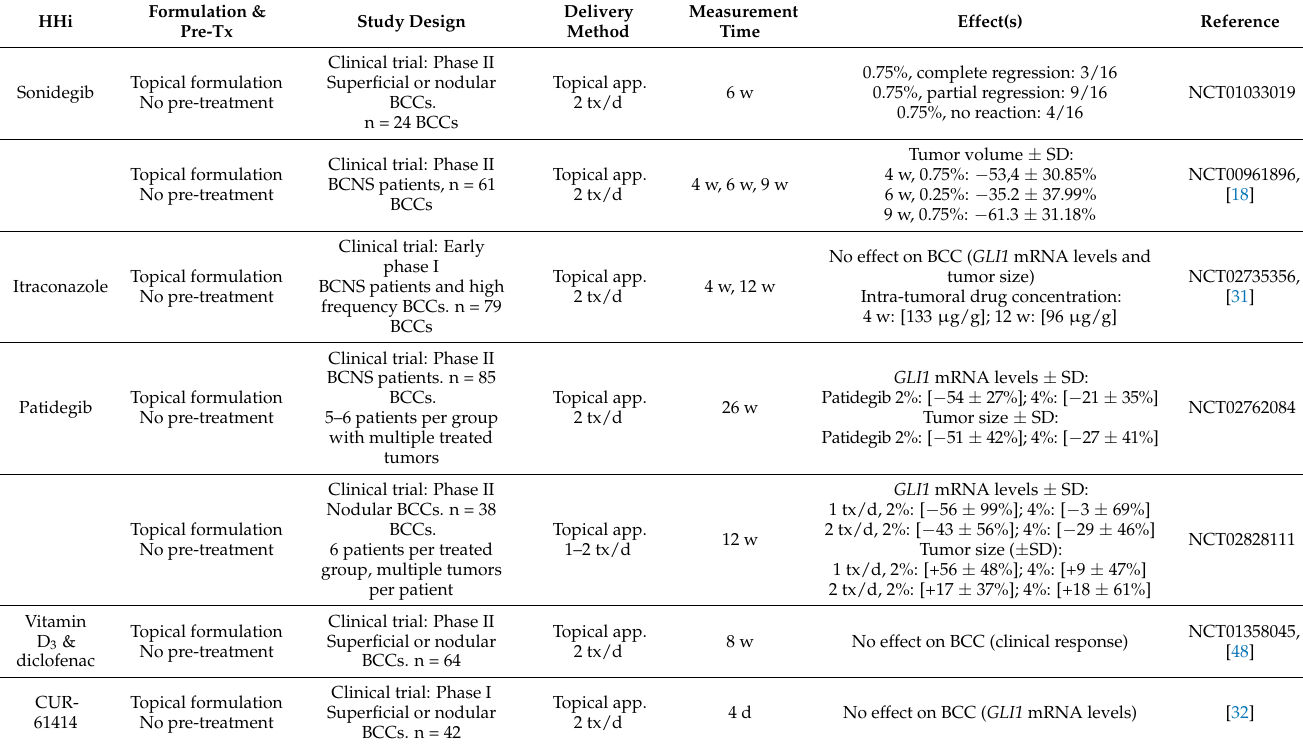
Table 4. Overview of included clinical